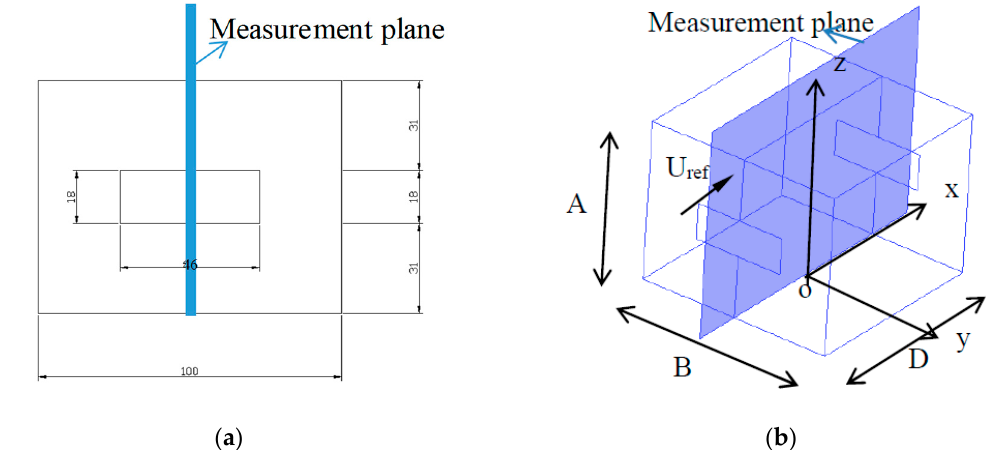
Figure 1. ( a ) Front view of scaled model with opening size and dimensions; ( b ) Measurement plane for the configuration of 10% wall porosity.